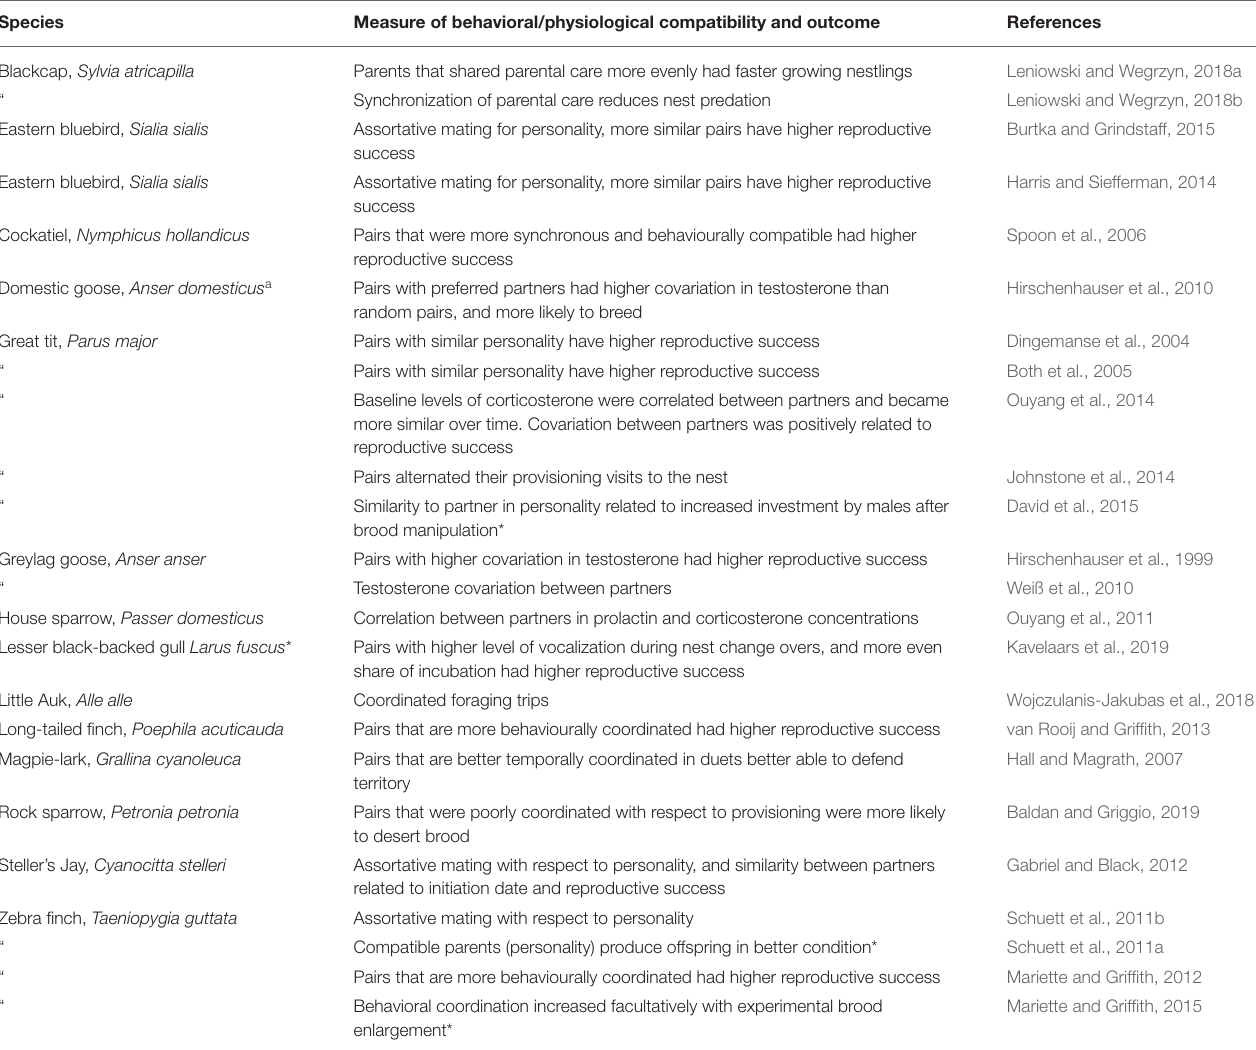
TABLE 2 | Studies supporting behavioral or physiological compatibility of partnerships in socially monogamous species.